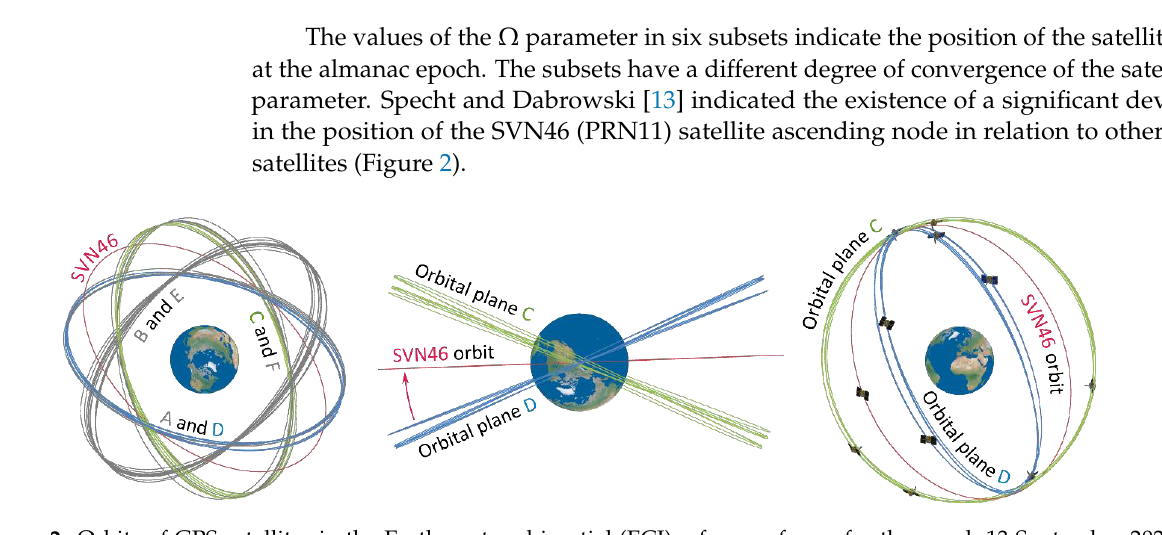
Figure 2. Orbits of GPS satellites in the Earth-centered inertial (ECI) reference frame for the epoch 13 September 2020, 12:41:54 UTC.